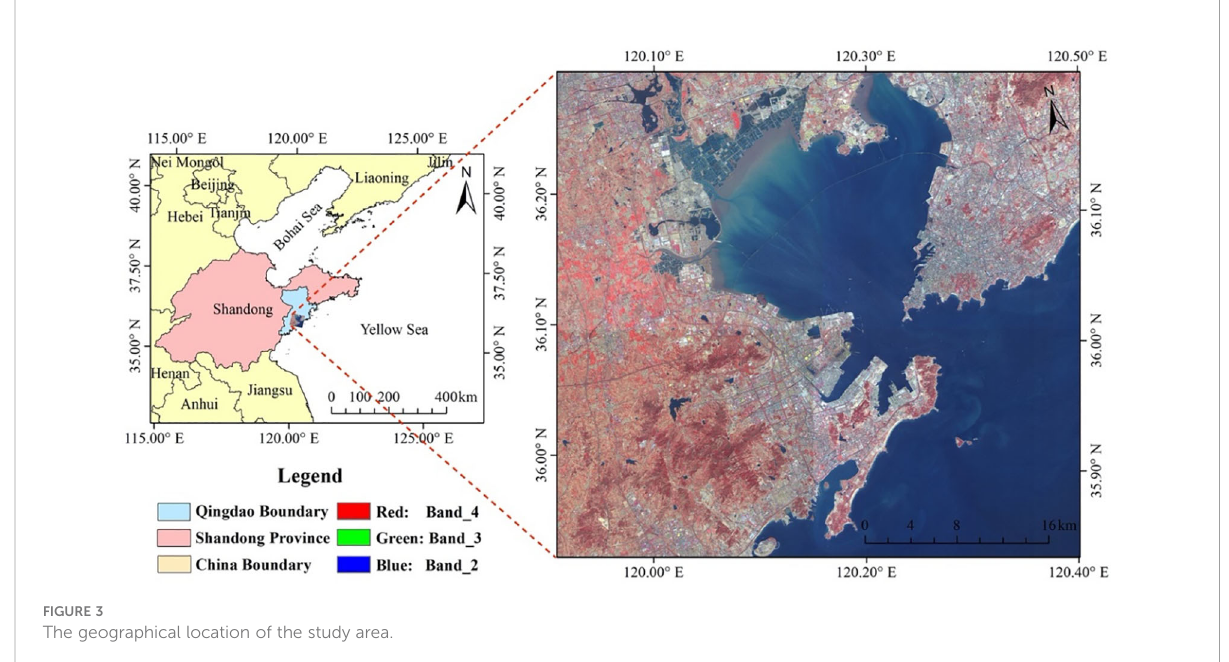
FIGURE 3 The geographical location of the study area.